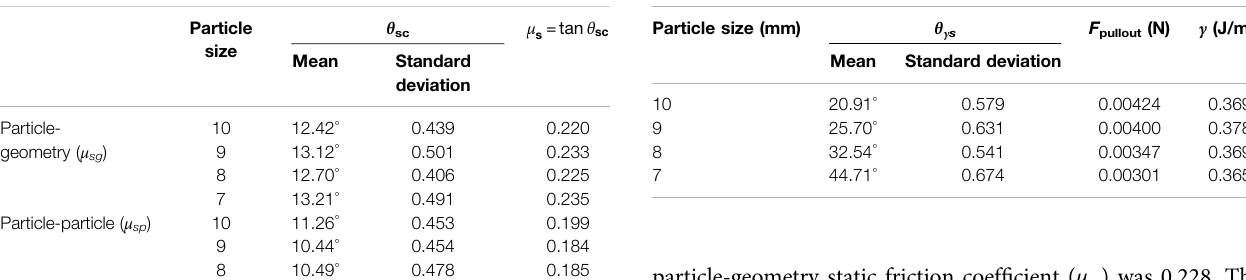
TABLE 6 | The surface energy test results of B1